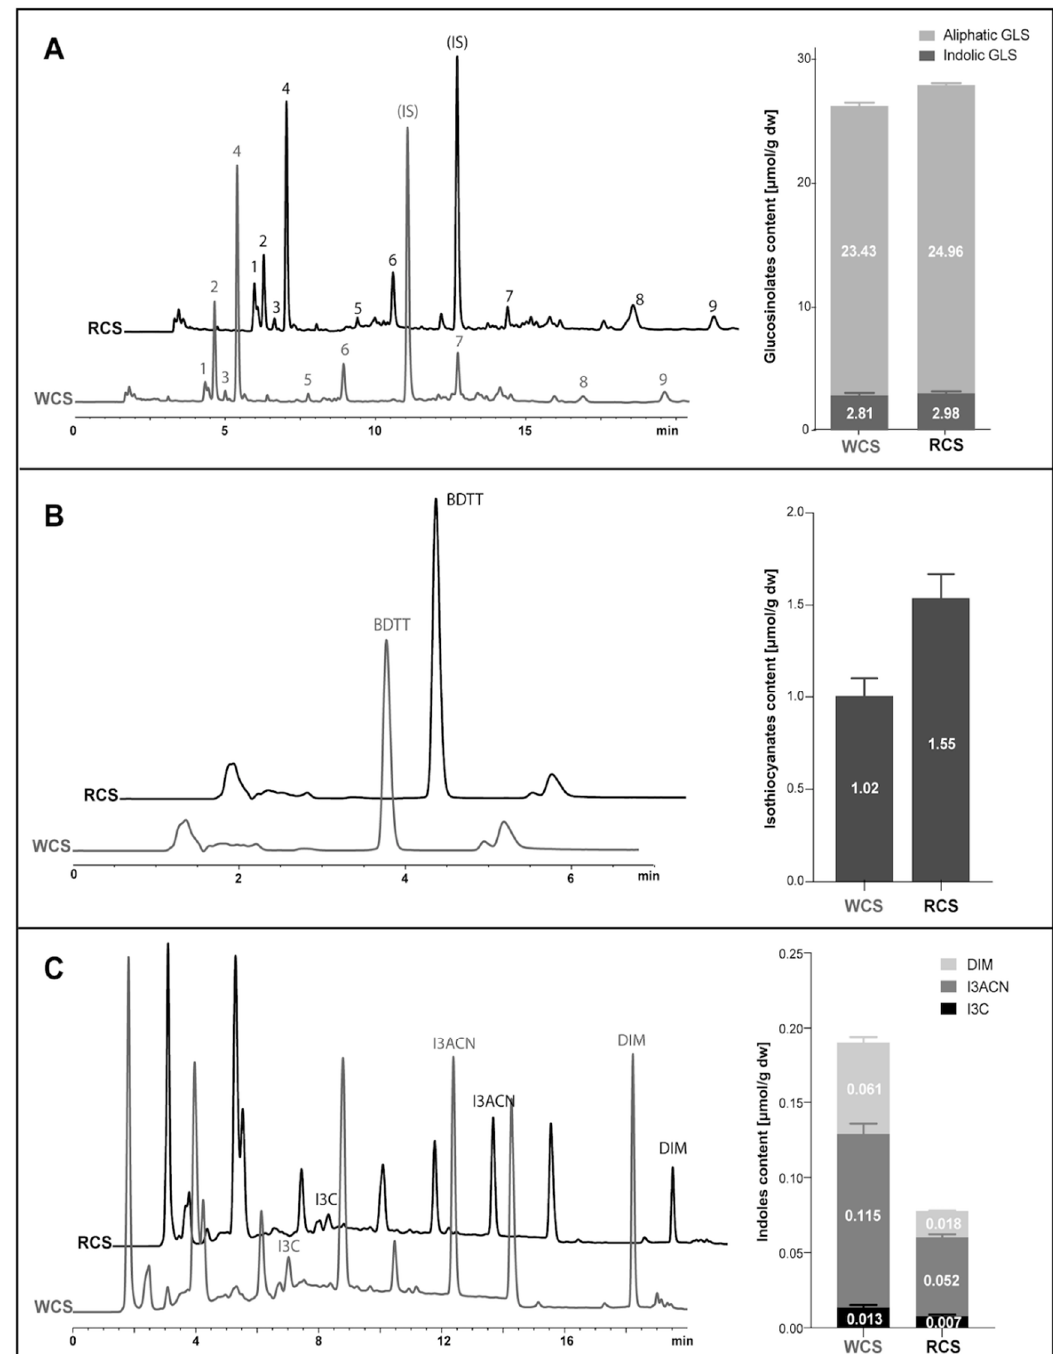
Figure 2. The chromatograms of glucosinolates ( A ) and products of their autolysis: isothiocyanates ( B ) and indoles ( C ) obtained during HPLC analyses of extracts obtained from white and red cabbage shoots (WCS and RCS, respectively). The glucosinolates were determined as desulfo- derivatives and chromatograms were recorded at 229 nm. The names of glucosinolate peaks are given in Table 1. The total isothiocyanates content were determined after cyclocondensation reaction with 1,2-benzenodithiol to 1,3-benzeneditiole-2-thione (BDTT) that peaks were registered at 365 nm. The detection of indolic products of degradation of glucosinolates was performed with the use of fluorescence detector (ex./em.—280/360 nm). Abbreviation used: IS, internal standard; I3C, indole-3-carbinol; I3ACN, indole-3-acetonitrile; DIM, diindolylmethane. The examined shoots of young white cabbage were found to have the highest amount In total glucosinolates content of young shoots of both red- and white headed cab- of sinigrin (SIN) (60.4%), followed by progoitrin (PRO/e-PRO) (28.6%) and bage, the share of aliphatic glucosinolates was highest and was 23.42 and 24.96 µmol/1 g